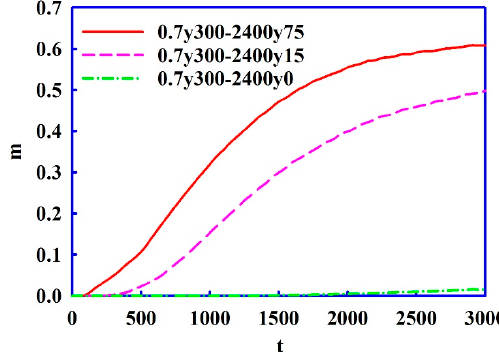
Figure 9. Normalized mixing efficiency m for mixing between a puff released at the channel center (puff A: Sc = 0.7, y o = 300) and puffs of drastically different S c values ( Sc = 2400) released at distances y o = 75, 15, and